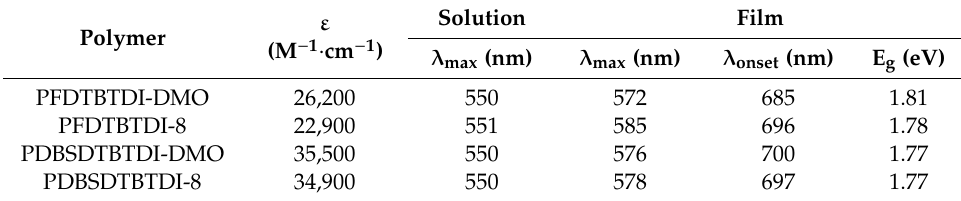
Figure 1. Normalized UV-vis absorption spectra of PFDTBTDI-DMO, PFDTBTDI-8, PDBSDTBTDI-DMO, and PDBSDTBTDI-8 in ( a ) chloroform solutions; and ( b ) thin films. Table 2. The UV-vis data and optical band gaps of the Table 2. The UV-vis data and optical band gaps of the polymers.